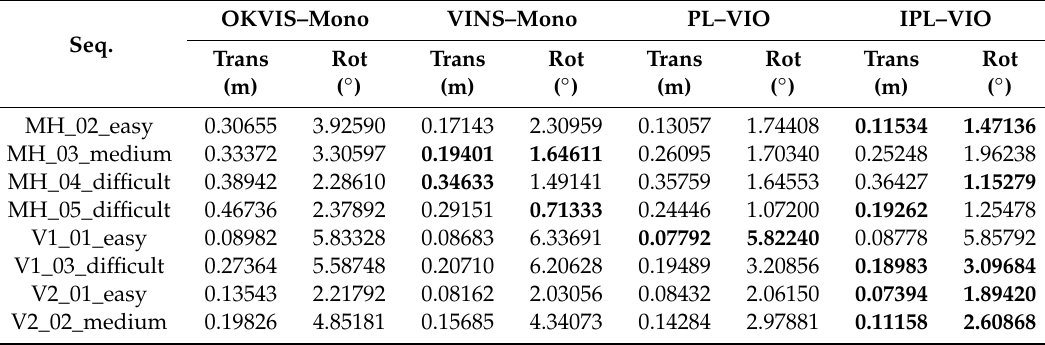
Table 2. The root mean square error (RMSE) results on several EuRoc MAV datasets.